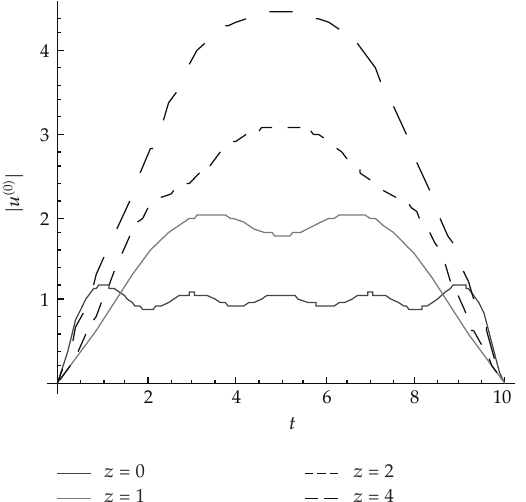
Figure 20: The zero-order approximation | u (cid:3) 0 (cid:4) | at α (cid:8) 1, T (cid:8) 10, γ (cid:8) 02 for di ff erent values of z , considering only one term in the series (cid:3) M (cid:8) 1 (cid:4) .